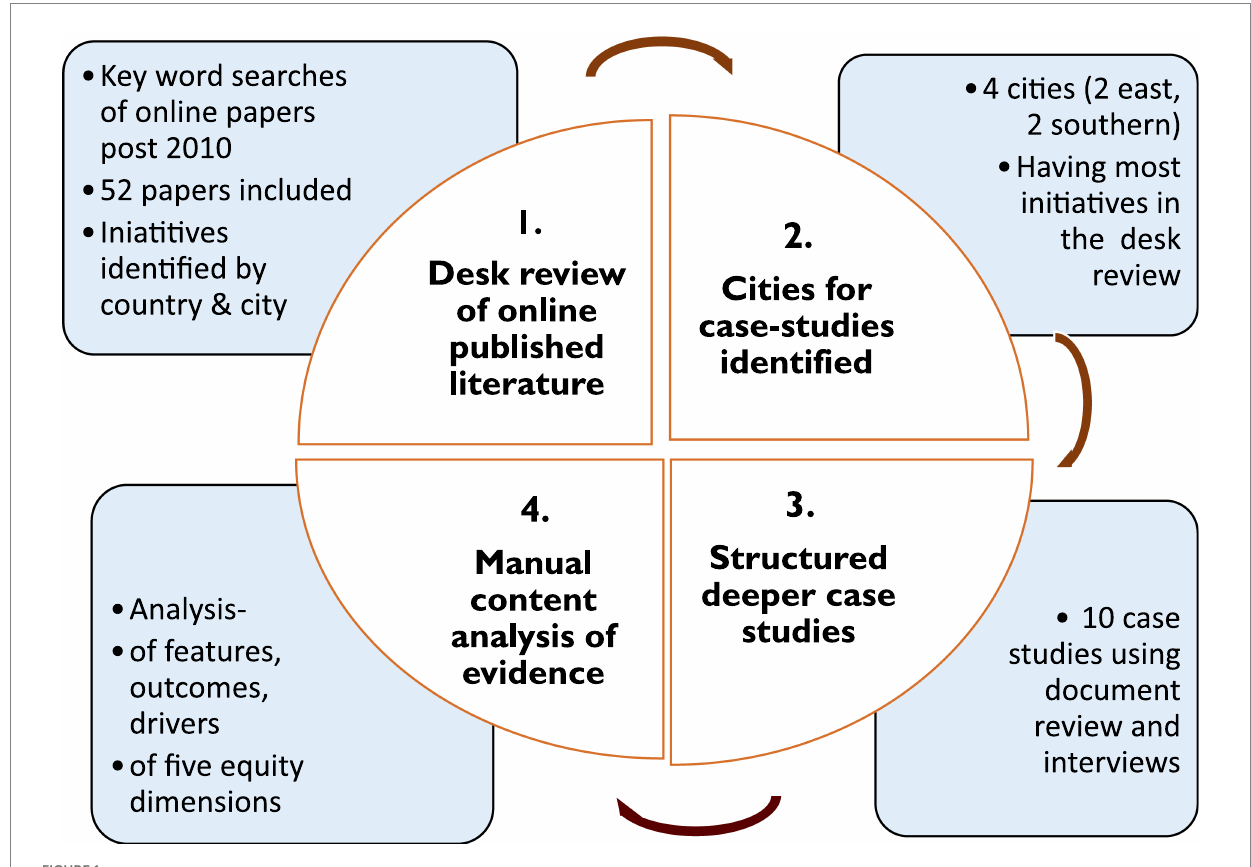
FIGURE 1 Steps followed in the